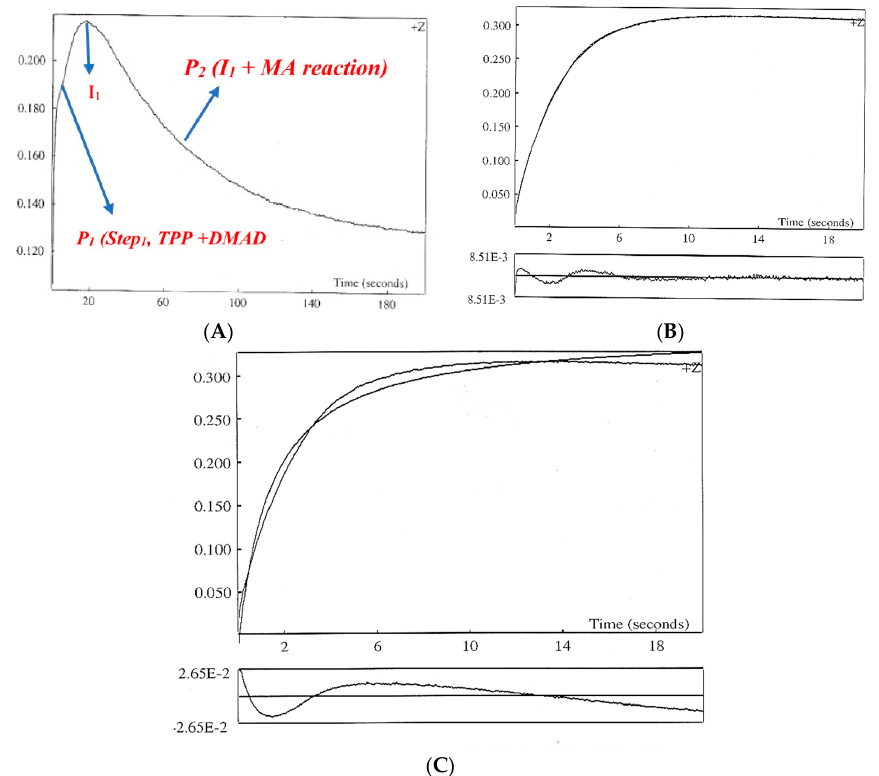
Figure 4. Analyzed kinetic traces for the reaction between TPP, DMAD and MA: ( A ) the stopped-flow spectra at 320 nm and 20 ◦ C in ethanol involving Parts P 1 (TPP + DMAD reaction) and P 2 (I 1 + MA reaction); ( B ) second-order fit curve for the expanded part (P 1 , Step 1, k 1 ), which exactly fits to the original experimental curve at 320 nm and 20 ◦ C in ethanol using the stopped-flow technique; ( C ) first-order fit curve for the expanded part (P 1 , Step 1, k 1 ), which does not fit appropriately to the original experimental curve at 320 nm and 20 ◦ C. P 1 is relevant to the reaction between TPP and DMAD for the generation of I 1 . P 2 is relevant to the reaction between I 1 and